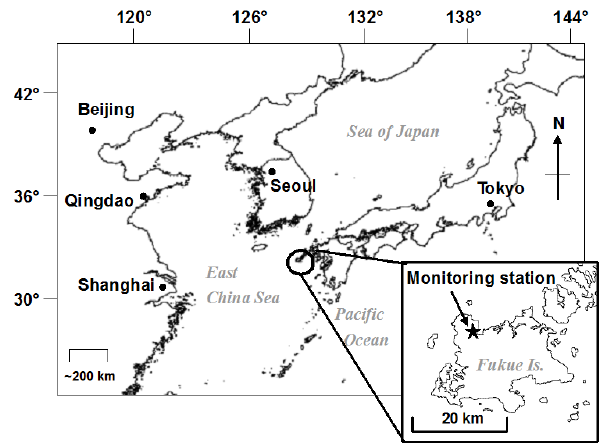
Figure 1. Location of the Fukue Island monitoring station.